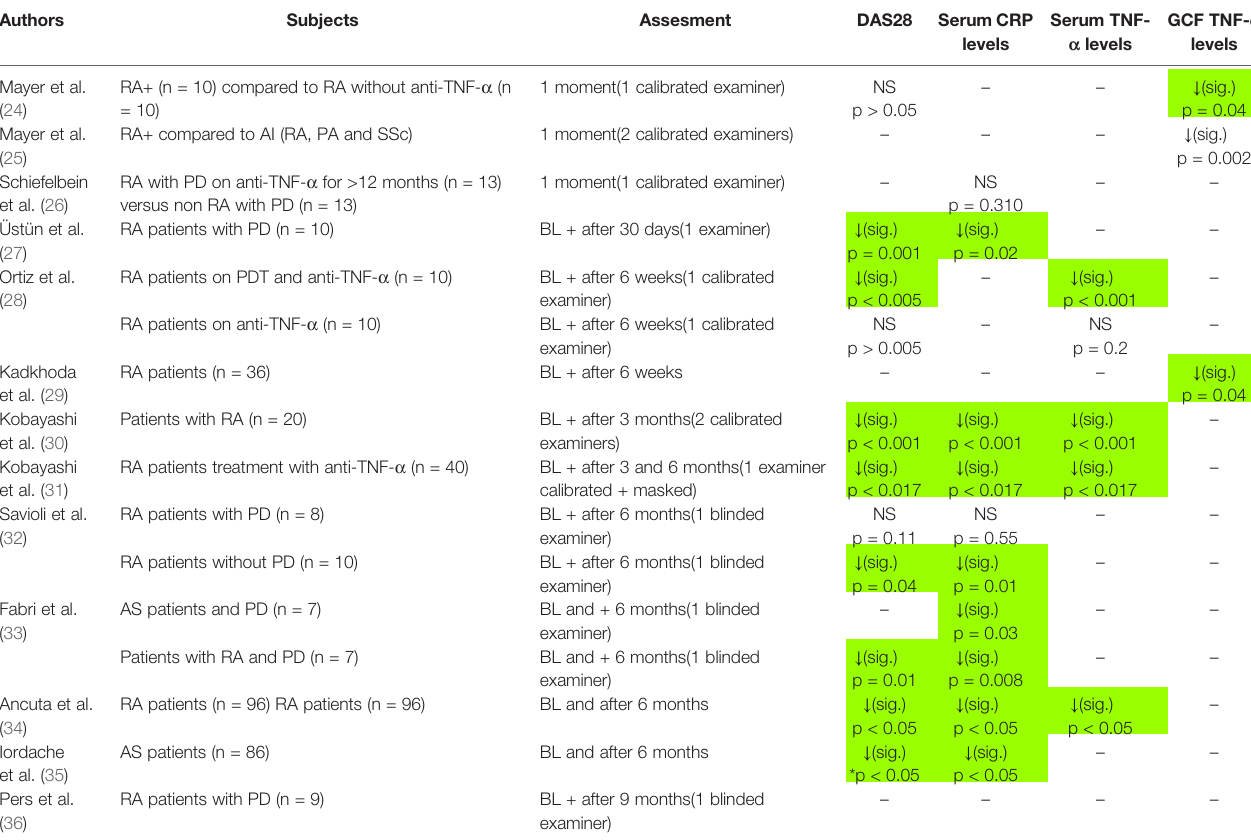
TABLE 3 | Studies assessing the effect of TNF inhibitors on rheumatologic parameters and cytokine